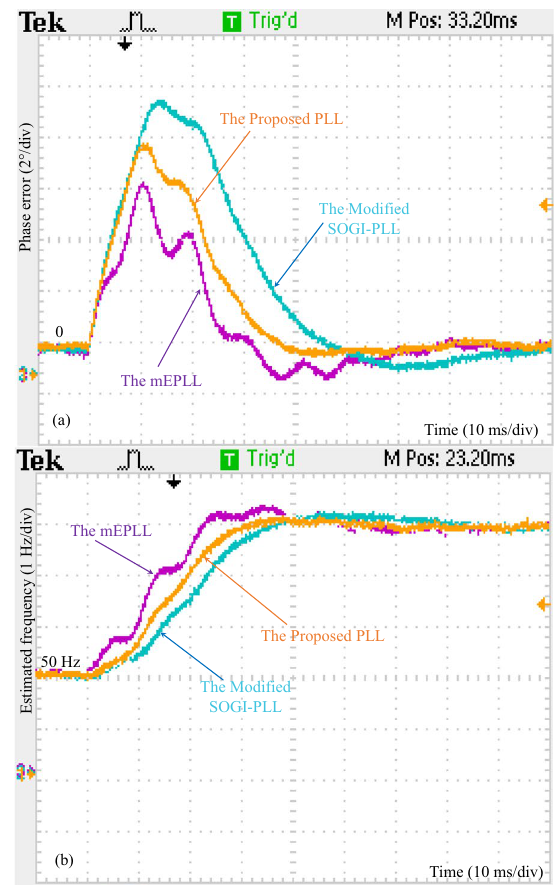
Fig. 15 Experimental results under a sudden change of 3 Hz grid frequency. CH1, CH2, and CH3 show the responses of the proposed PLL, mEPLL, and modified SOGI-PLL, respectively. a Estimated